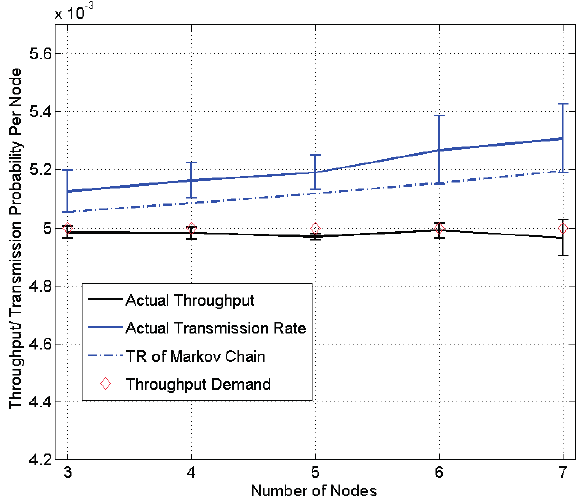
Figure 6. Experiment results of homogeneous networks (TR: transmission rate).